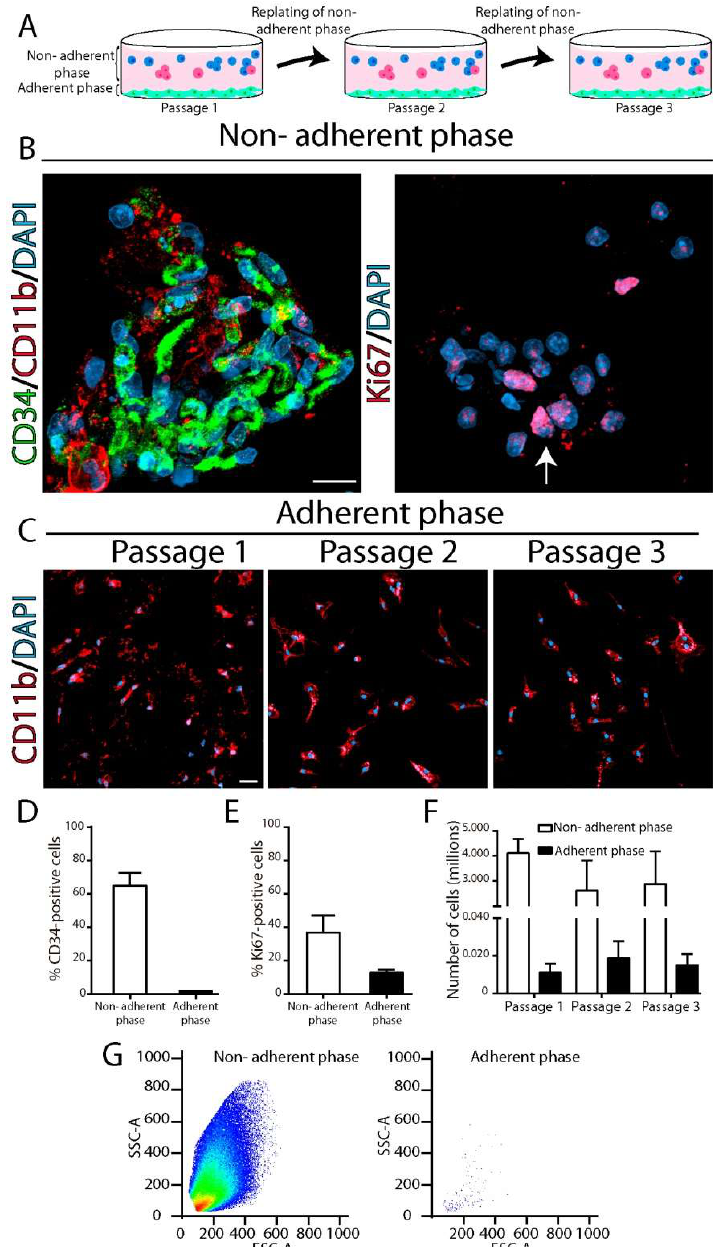
Figure 6. Characterization of CD34 + cells in primary spinal cord cultures from symptomatic SOD1 G93A rats. Primary cultures were prepared from symptomatic rat’s ( n = 6) spinal cords and cells from the adherent and non-adherent phases were characterized. ( A ) Scheme showing the method used for analyzing the CD34 + and microglia cells (green attached cells) found in non-adherent cells (blue and red cells represent the heterogeneity of cultured non-adherent cells) after successive passages. ( B ) Cytological analysis of cell clusters found in the non-adherent phase showing CD34 + (green) and CD11 + (red, in left panel) cells as well as active proliferation as denoted by Ki67 nuclei staining (red, in right panel). ( C ) Immunostaining of adherent cells in successive passages showing sustained number of CD11b + cells (red). ( D ) Quantitative analysis showing CD34 + cells only in the non-adherent phase. ( E ) Quantitative analysis of Ki67 + cells in the non-adherent and adherent phase. ( F ) Quantitative analysis showing that cells accumulate in great number in the non-adherent phase and generate adherent CD11b + microglia in successive passages. ( G ) Representative plots of flow cytometry analysis showing the density of cells in both non-adherent and adherent phases. Scale bars: 10 µ m ( B ) and 25 µ m ( C